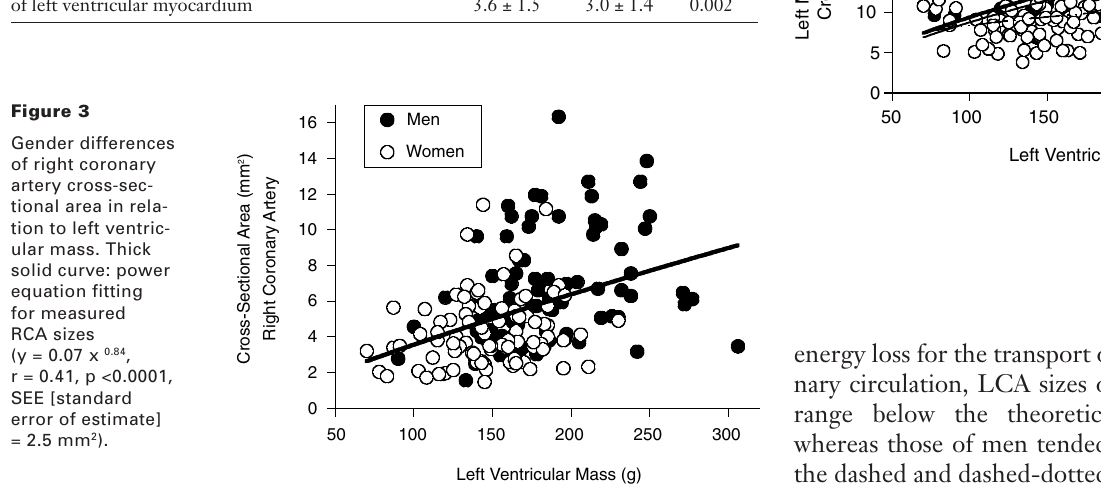
the dashed and dashed-dotted curves in figure